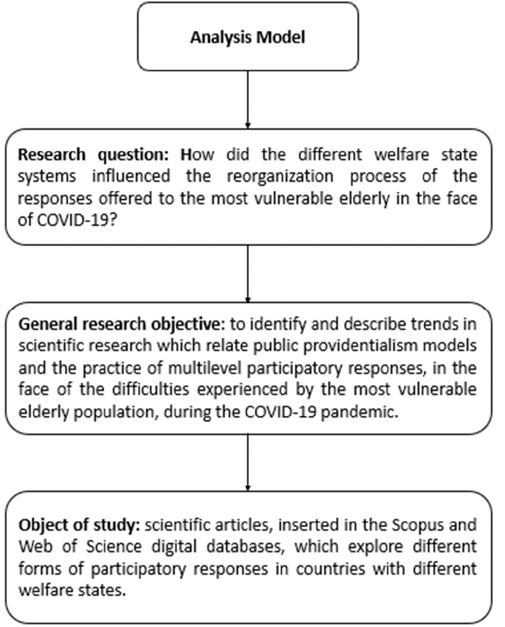
Figure 1. Summary of the analysis model of the present study.